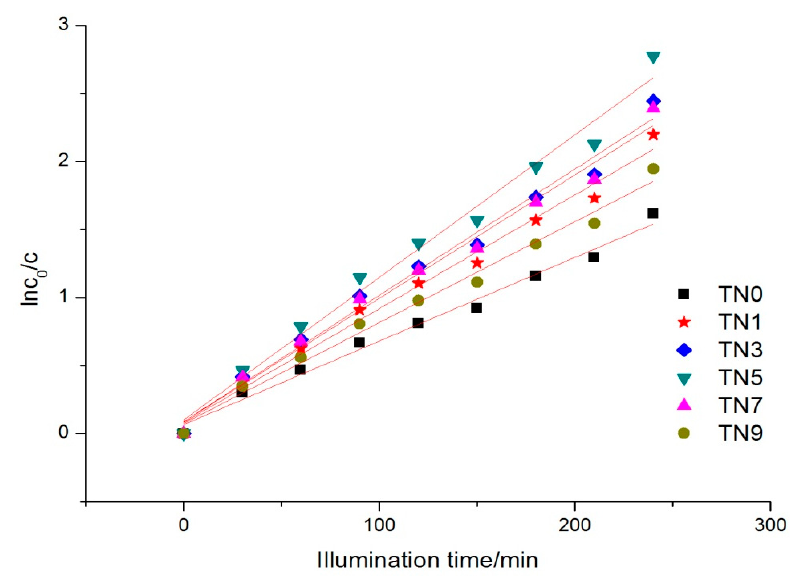
Figure 4. Phenol concentration trend under UV light.